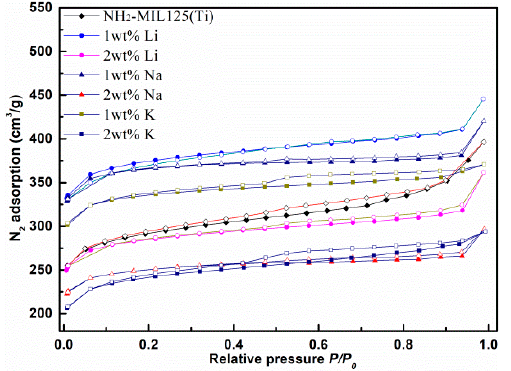
Figure 7. N 2 adsorption isotherms at 77 K for NH 2 –MIL125(Ti) and x M@NH 2 –MIL125(Ti).